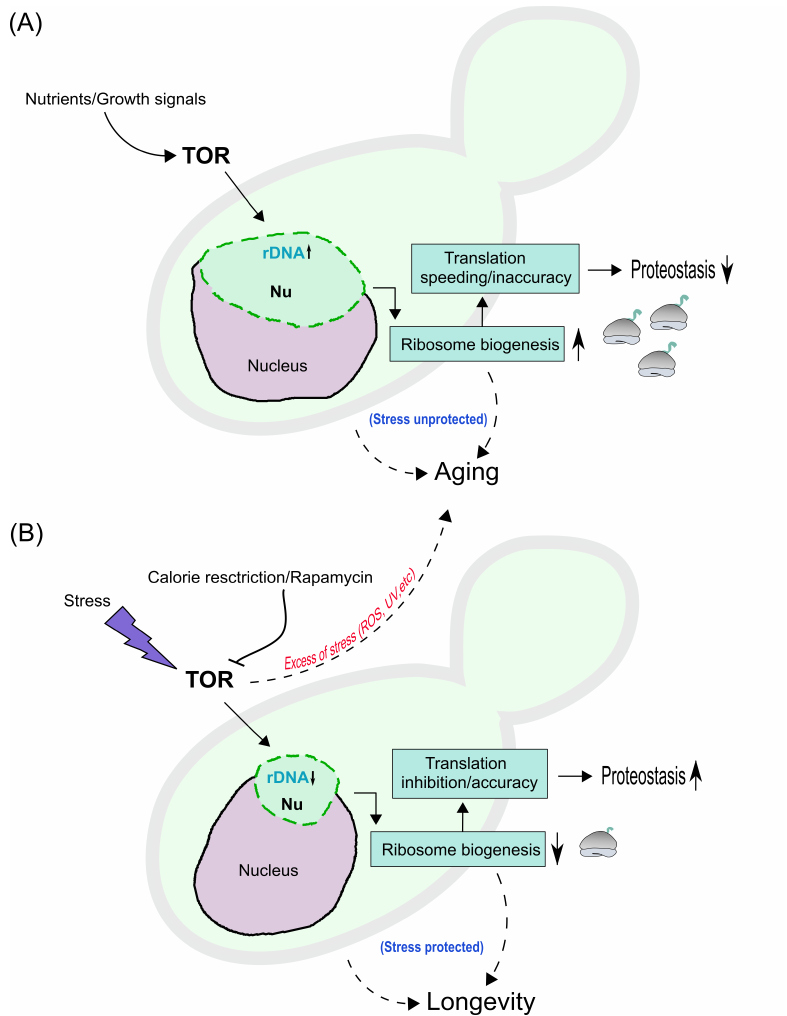
Figure 3. Hypothetical model for nucleolar condensation and aging/longevity mechanisms in yeast cells. ( A ) Nutrients and growth signals stimulate the Target Of Rapamycin ( TOR ), leading to rDNA transcription in the nucleolus ( Nu ), which acquires an enlarged nucleolar phenotype (green); as a result, ribosome biogenesis increases, depicted on the right as ribosomes (grey) with ongoing translation (green ribbons). This impinges on the rate and accuracy of translation, increasing the former while decreasing the latter, thus compromising proteostasis. This will lead in turn to an ’unprotected stress’ mode and to aging (dashed line with arrow on the right). Other intrinsic mechanisms dowstream of TORC1 (e.g., mitochondrial dysfunction, autophagy inhibition, etc.) can additionally lead to aging (dashed line on the left). ( B ) Calorie restriction, rapamycin and stress inhibit TOR, leading to rDNA transcription inhibition and to condensation of the nucleolus (small nucleolar phenotype); reducing ribosome biogenesis, while inhibiting translation rate and/or increasing accuracy of translation, with improved proteostasis. This will lead in turn to a ’protected stress’ mode and to lifespan extension and longevity (dashed line on the right). Other intrinsic mechanisms can additionally lead to lifespan extension (dashed line on the left). Nevertheless, excess of stress (ROS: Reactive Oxygen Species, UV: Ultra Violet light, etc) can lead to aging (dashed line pointing towards panel